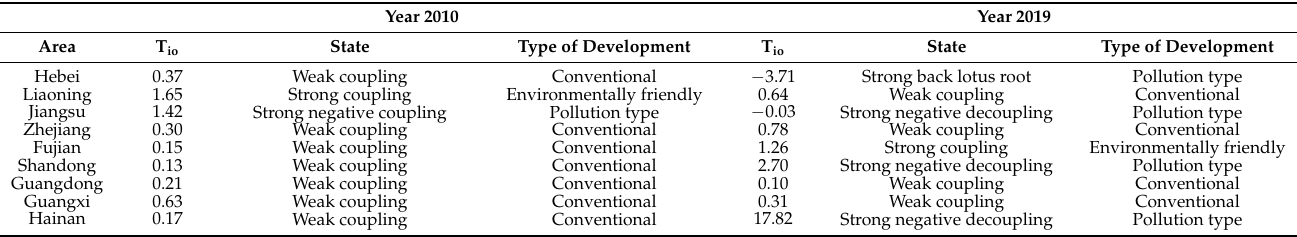
Table 16. Analysis of coupling relationship in nine coastal provinces.